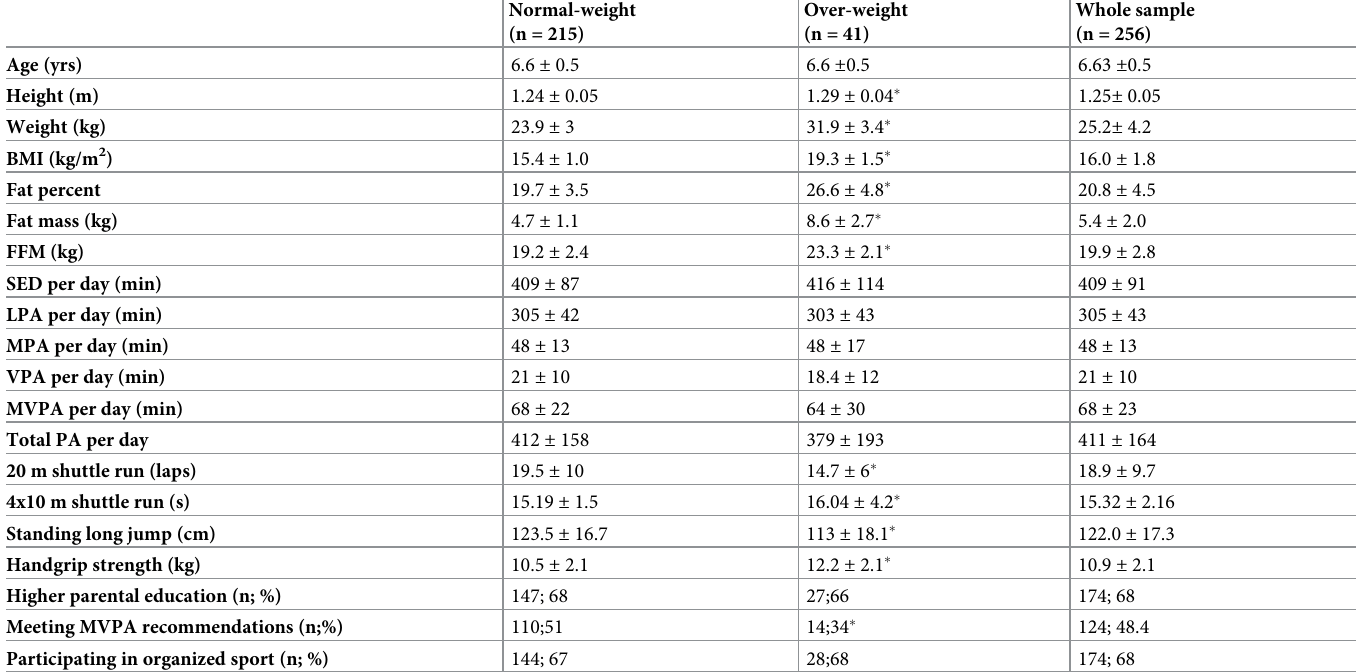
Table 1. Descriptive data of study